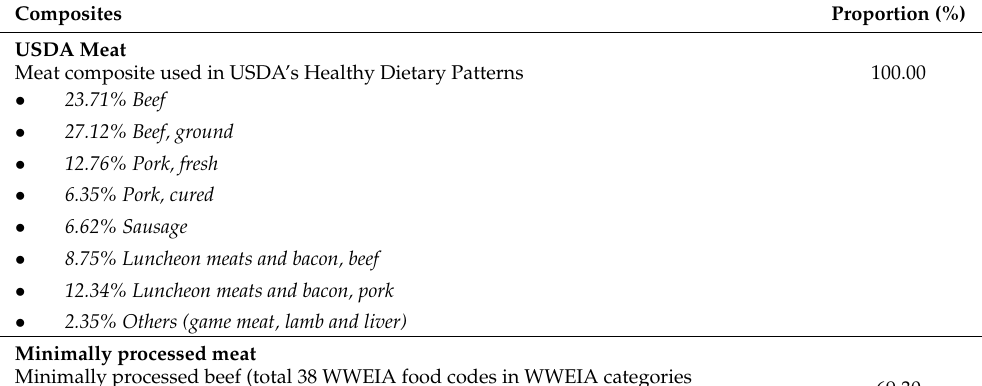
Table 1. Composition of meat and poultry